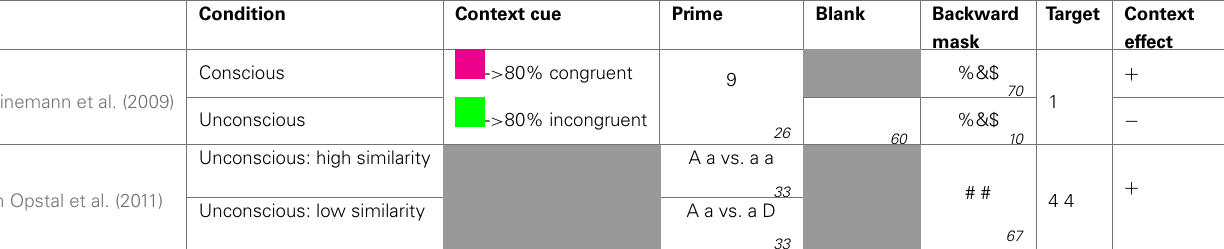
Table 3 | Schematic overview of studies looking at the possibility of unconscious context